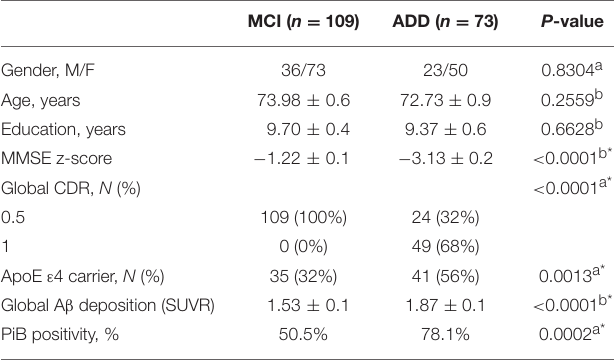
TABLE 1 | Demographic and clinical characteristics of